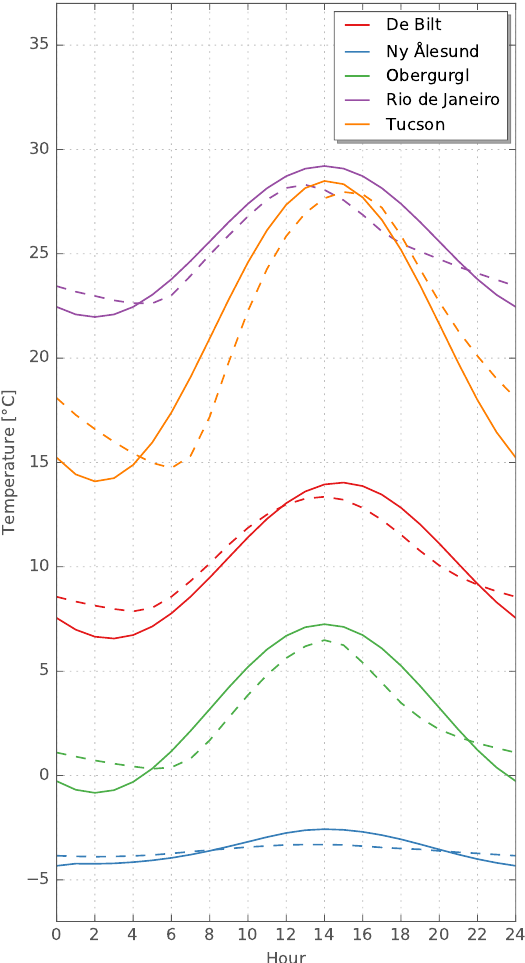
Figure 9. Long-term averages of diurnal courses of observed (dashed) and disaggregated (solid) temperature. Option T1b has been chosen and the sine curve was modelled based on sunset and sun noon computations for minimum and maximum temperature, respectively. The period of time involved in this analysis is listed in Table 1 for each